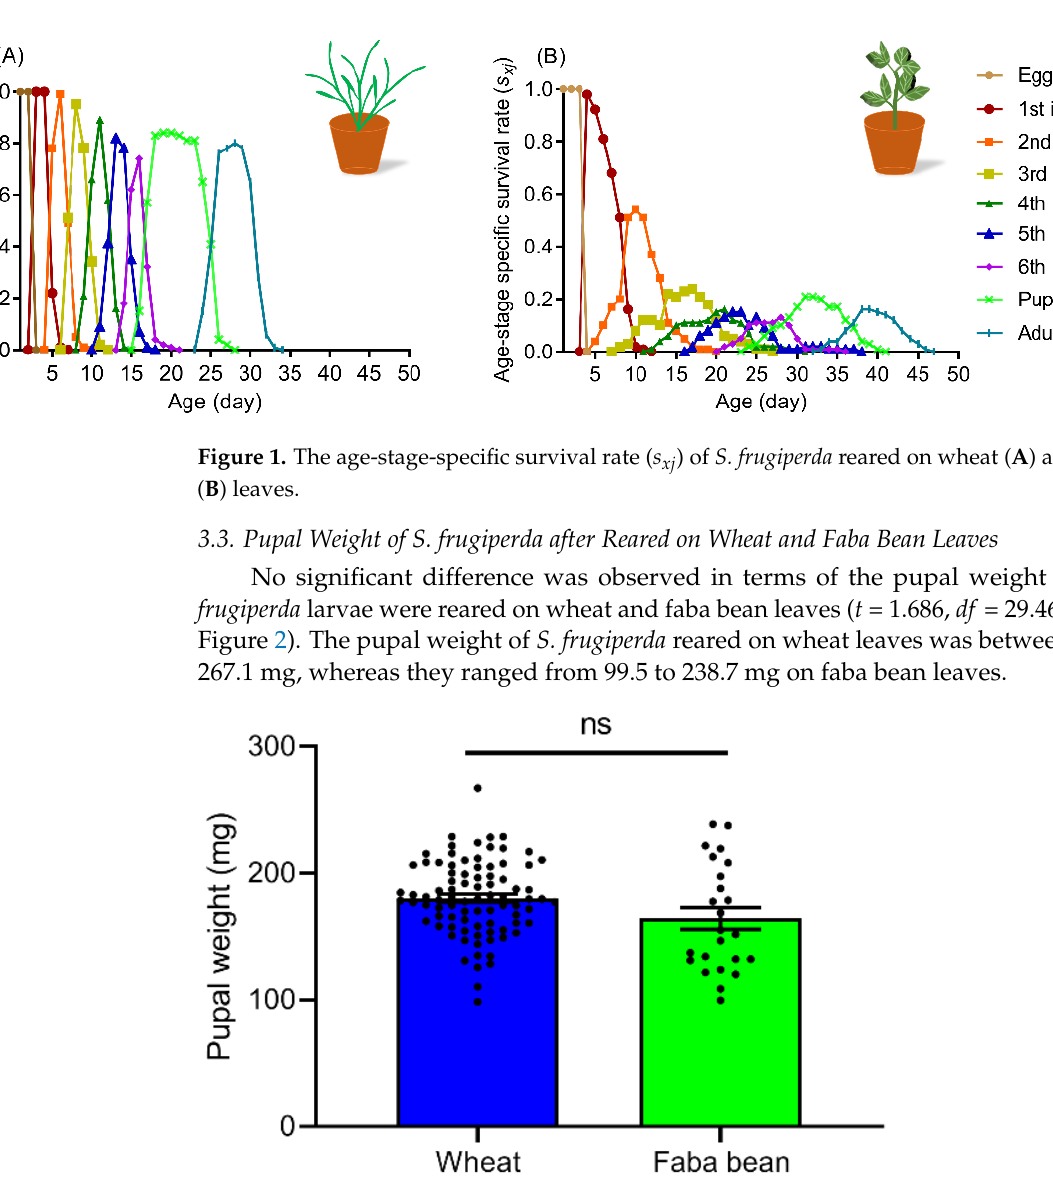
Figure 2. The pupal weight of S. frugiperda reared on wheat and faba bean leaves. All data are presented as the mean ± standard error (SE). The value bars with “ns” are insignificant (independent sample t-tests, p > 0.05).